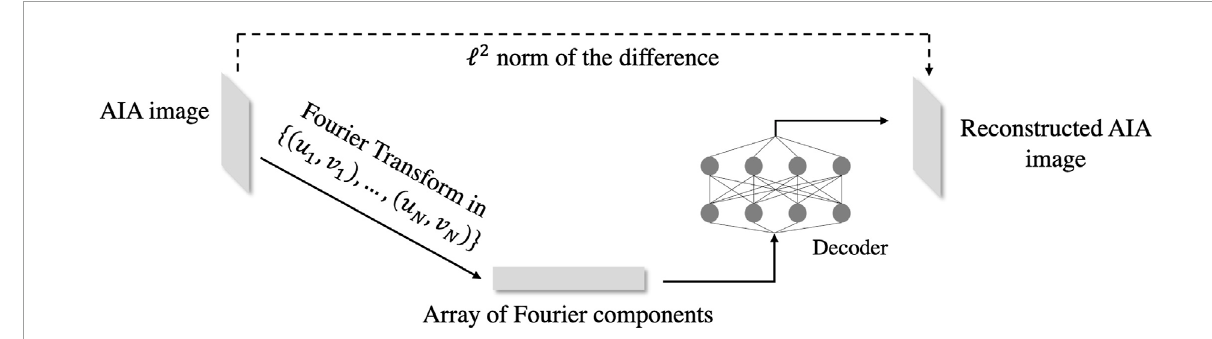
FIGURE 10 Neural network architecture that can be used for learning the best ( u , v ) coverage for representing an AIA image.